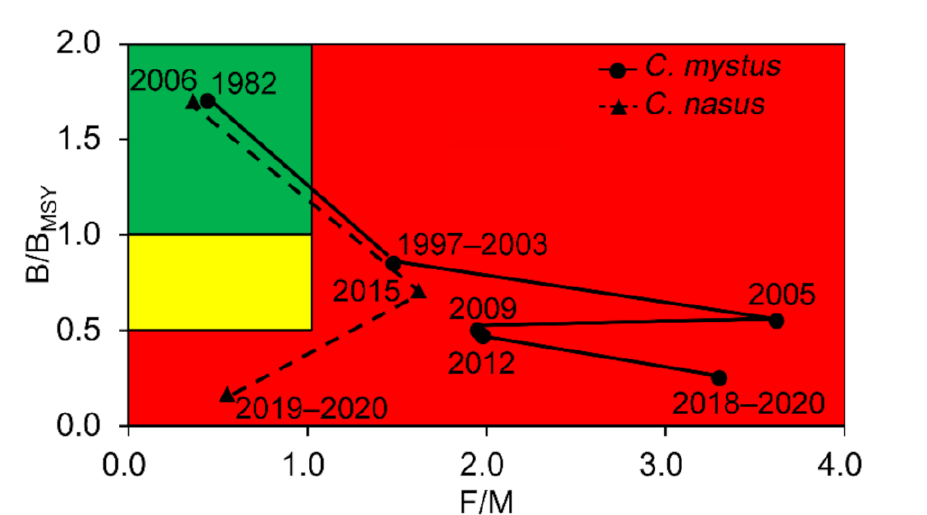
Figure 5. Trajectories of the relative biomass ( B / B MSY ) and fishing pressure ( F / M ) for C. mystus and C. nasus in the Yangtze River Estuary, China. Red area: stocks that are being overfished and/or are outside of safe biological limits; yellow area: recovering stocks; green area: stocks subject to sustainable fishing pressure and/or a healthy stock biomass that can produce high yields close to MSY. Note that the location of 2006 data point for C. nasus is very questionable (see